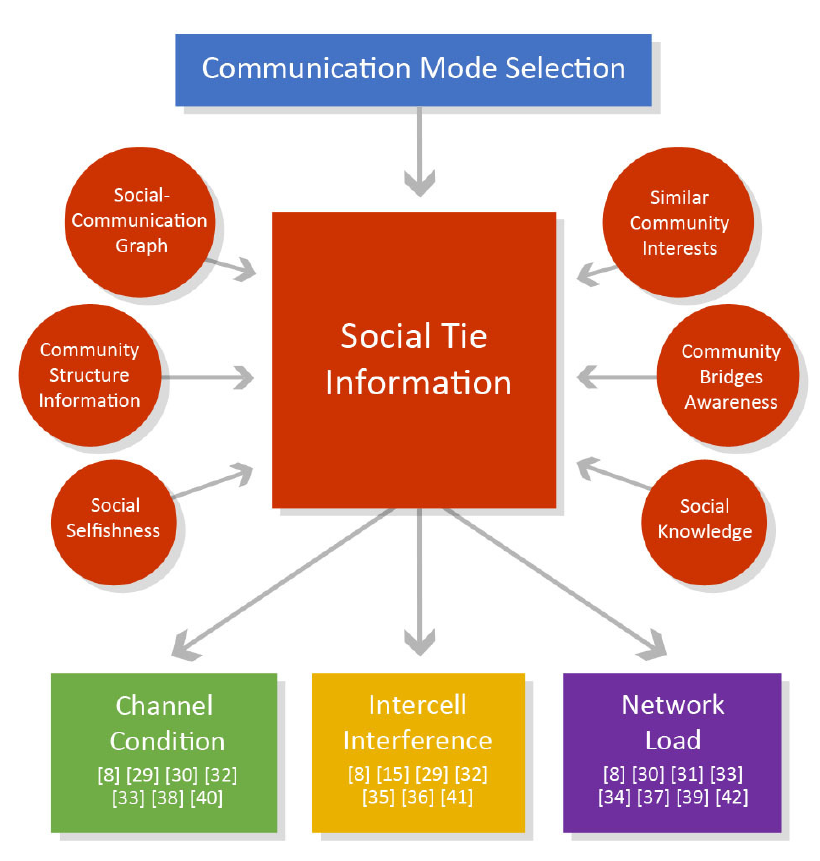
Figure 3. Enhancing the mode selection decision using social tie